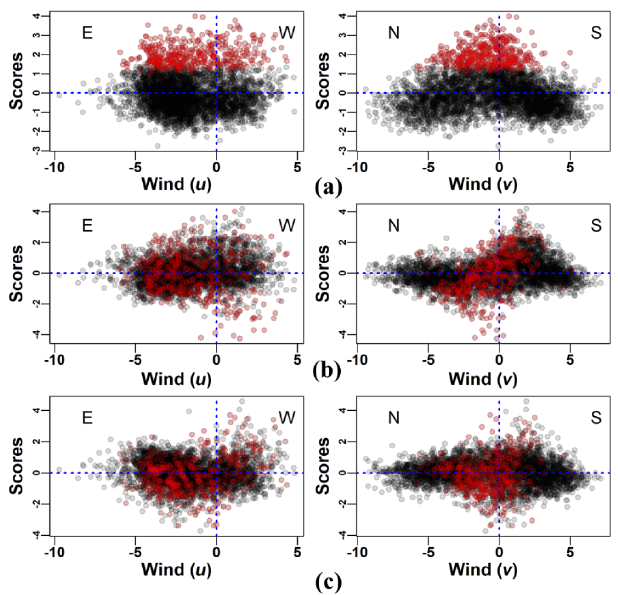
Figure 6. Scatterplot between principal component scores ( a – c : PC1-3) and wind ( u and v ). u and v are the east–west and north– south components of wind ( u : + west/-east; v : + south/-north). Red points refer to samples with high ozone concentrations (over the 90th